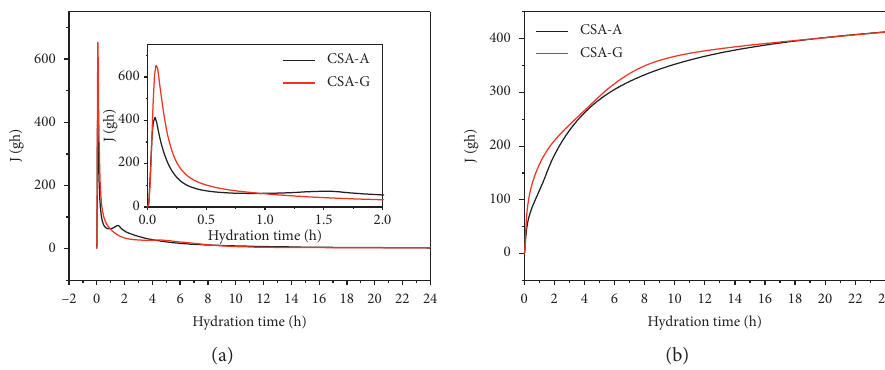
Figure 2: Hydration exothermic curve: (a) exothermic rate curve; (b) cumulative exothermic curve.